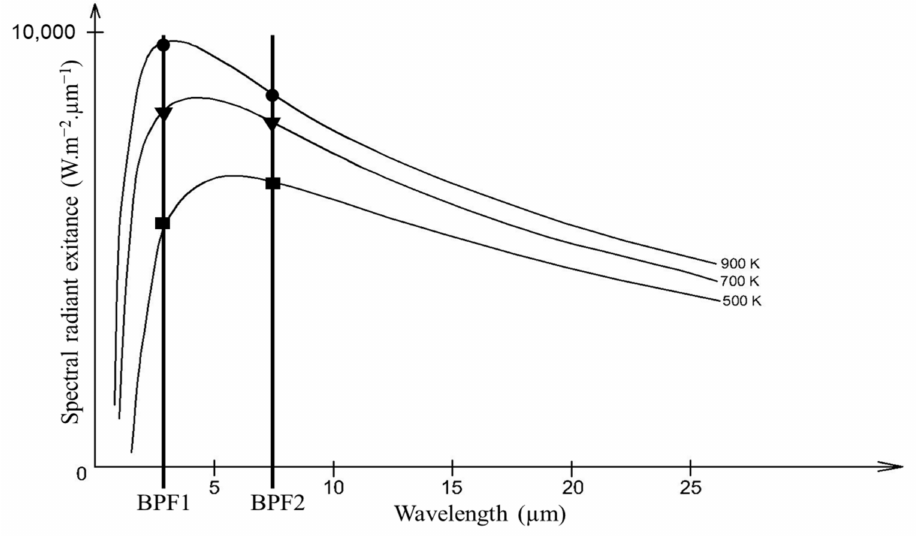
Figure 1. Relationship among the temperature of an IR source, wavelength, and spectral radiant exitance using Planck’s law adapted from